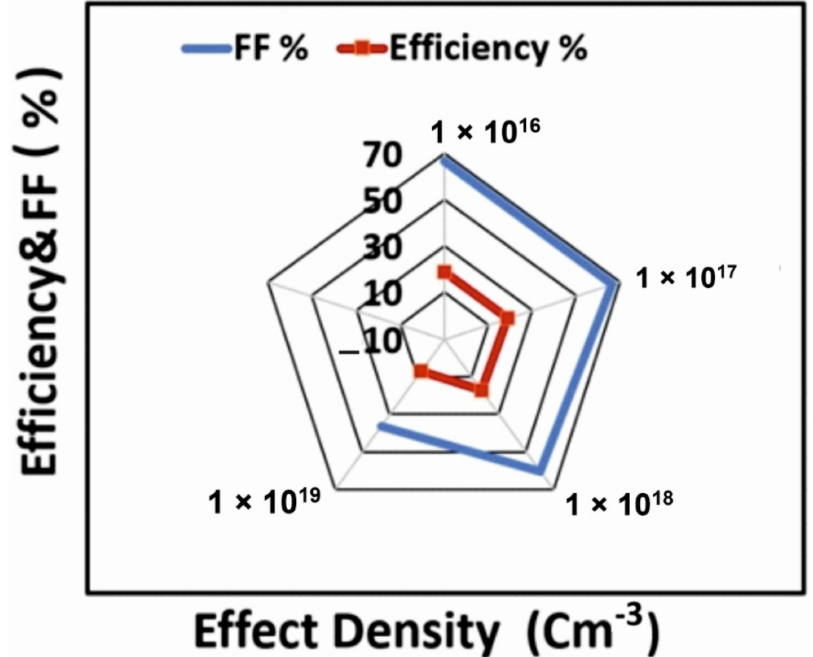
Figure 6. Efficiency and FF versus effect density for case